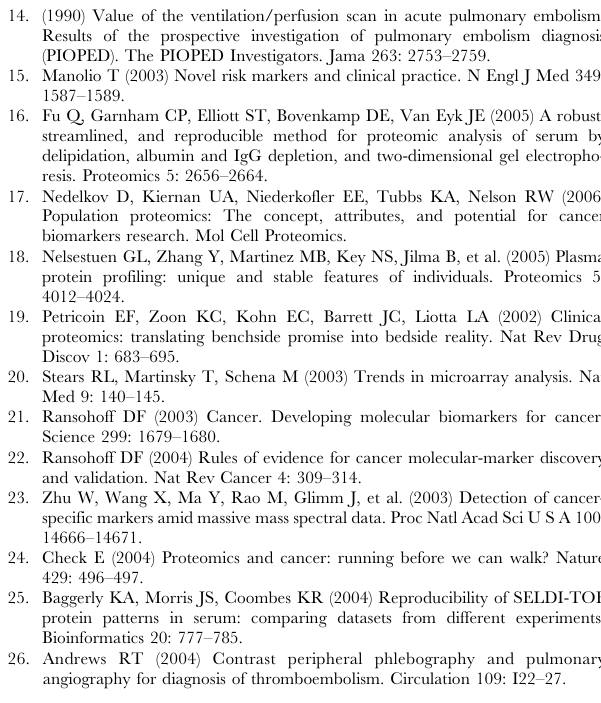
Figure S3 MS/MS data for haptoglobin. The raw chromato- gram is shown (a, upper panel) along with the chromatogram for the peptide YVMLPVADQDQCIR with observed mass of 854.41 Da (a, lower panel). MS of the peptide is shown (b), followed by the raw MS/MS data